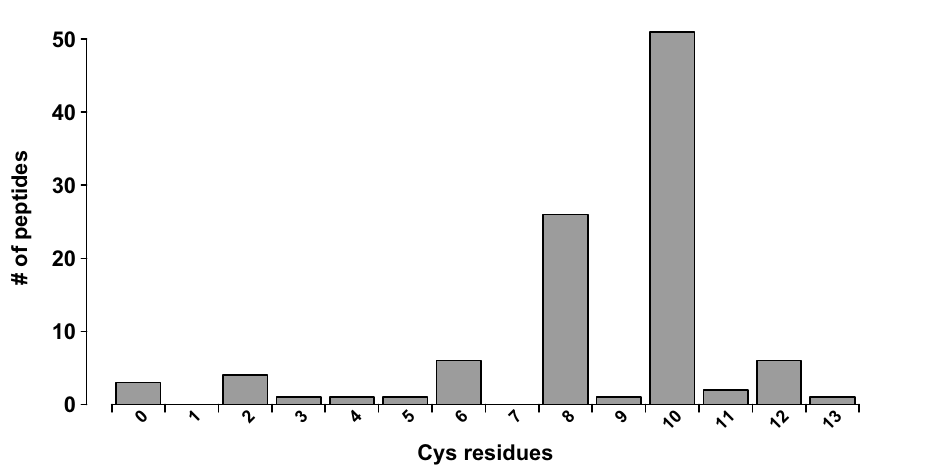
Figure 3. Distribution of peptides in the Lampona venom proteome according to the number of cysteines they contain. Note the high abundance of peptides with 8 or 10 cysteine